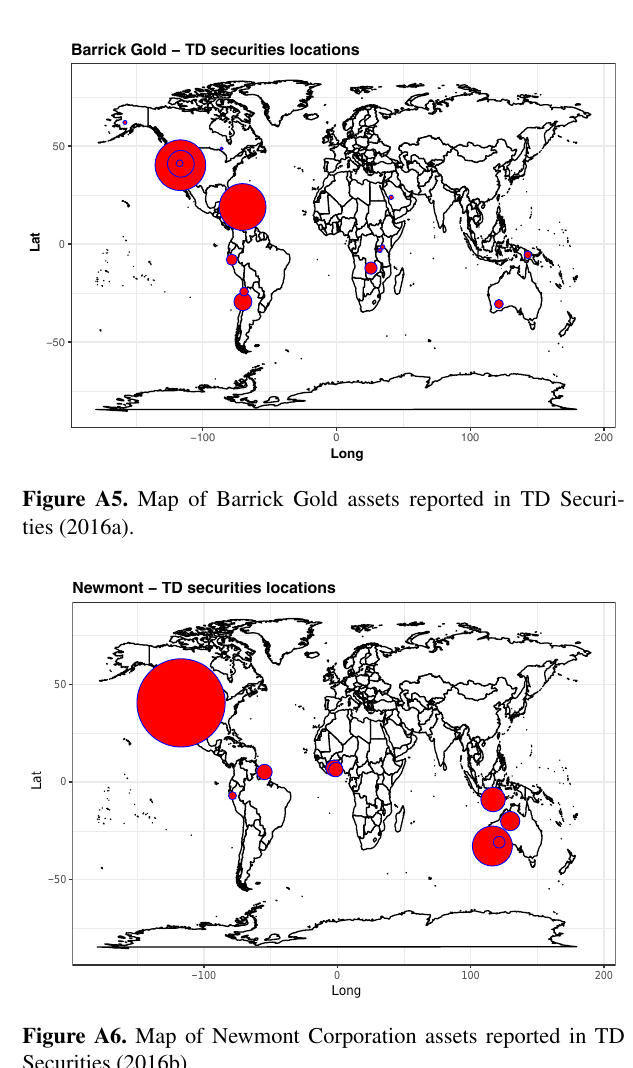
Figure A4. Map of Rio Tinto 2015 mining assets.